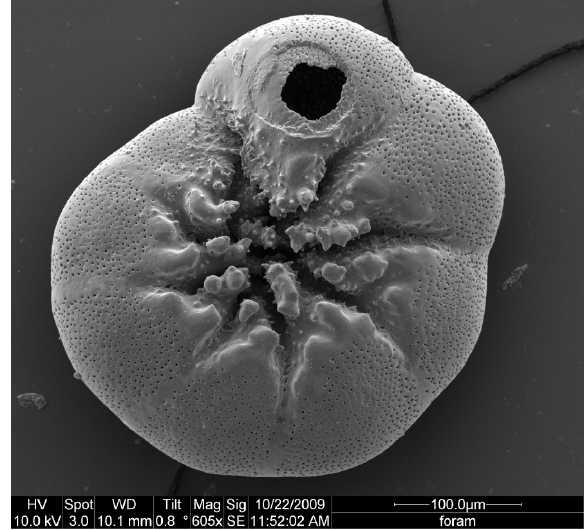
Fig. 2. Scanning electron microscope image of laser ablation crater in Ammonia tepida .